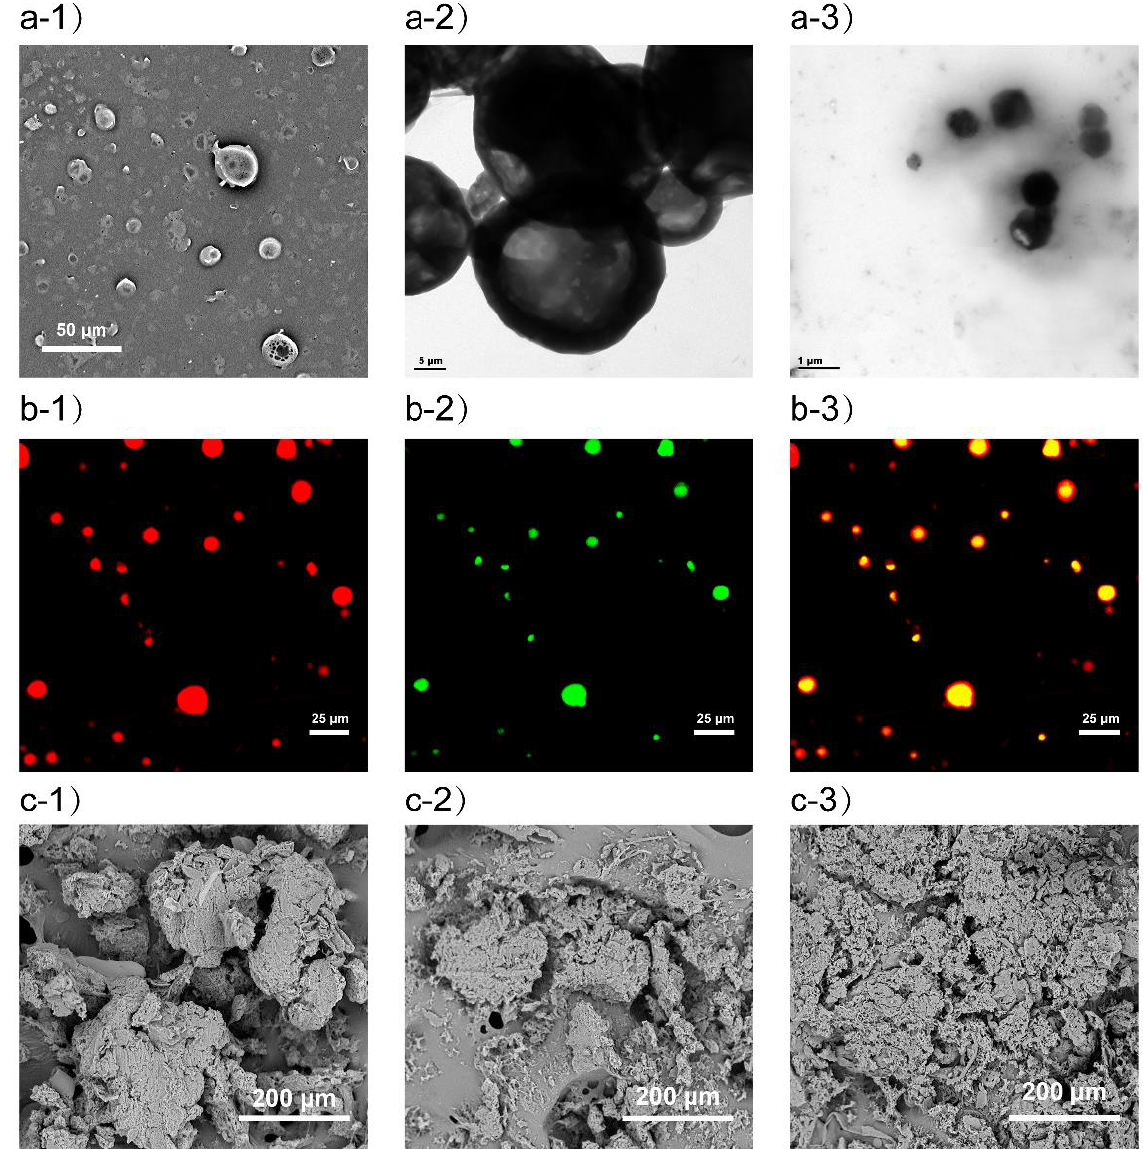
Figure 2. Morphology of core–shell microparticles composed of the PTX-loaded sodium hyaluronate outer layer and the IMN-loaded PLGA core (PHIPMPs): ( a-1 ) TEM morphology of PHIPMPs; ( a-2 ) TEM morphology of PHIPMPs incubated in a pH = 7.4-PBS solution for 5 min; ( a-3 ) TEM morphology of PHIPMPs incubated in pH7.4 PBS solution for 1 h; ( b-1 – b-3 ) Confocal microscopy image of fluorescent-labeled PHIPMPs; ( b-1 ) RhB, labeling the shell; ( b-2 ) coumarin-6, labeling the core; ( b-3 ) merged; ( c-1 – c-3 ) SEM morphology of PHIPMPs incubated in pH7.4 PBS for 3, 5, and 7 days, respectively.